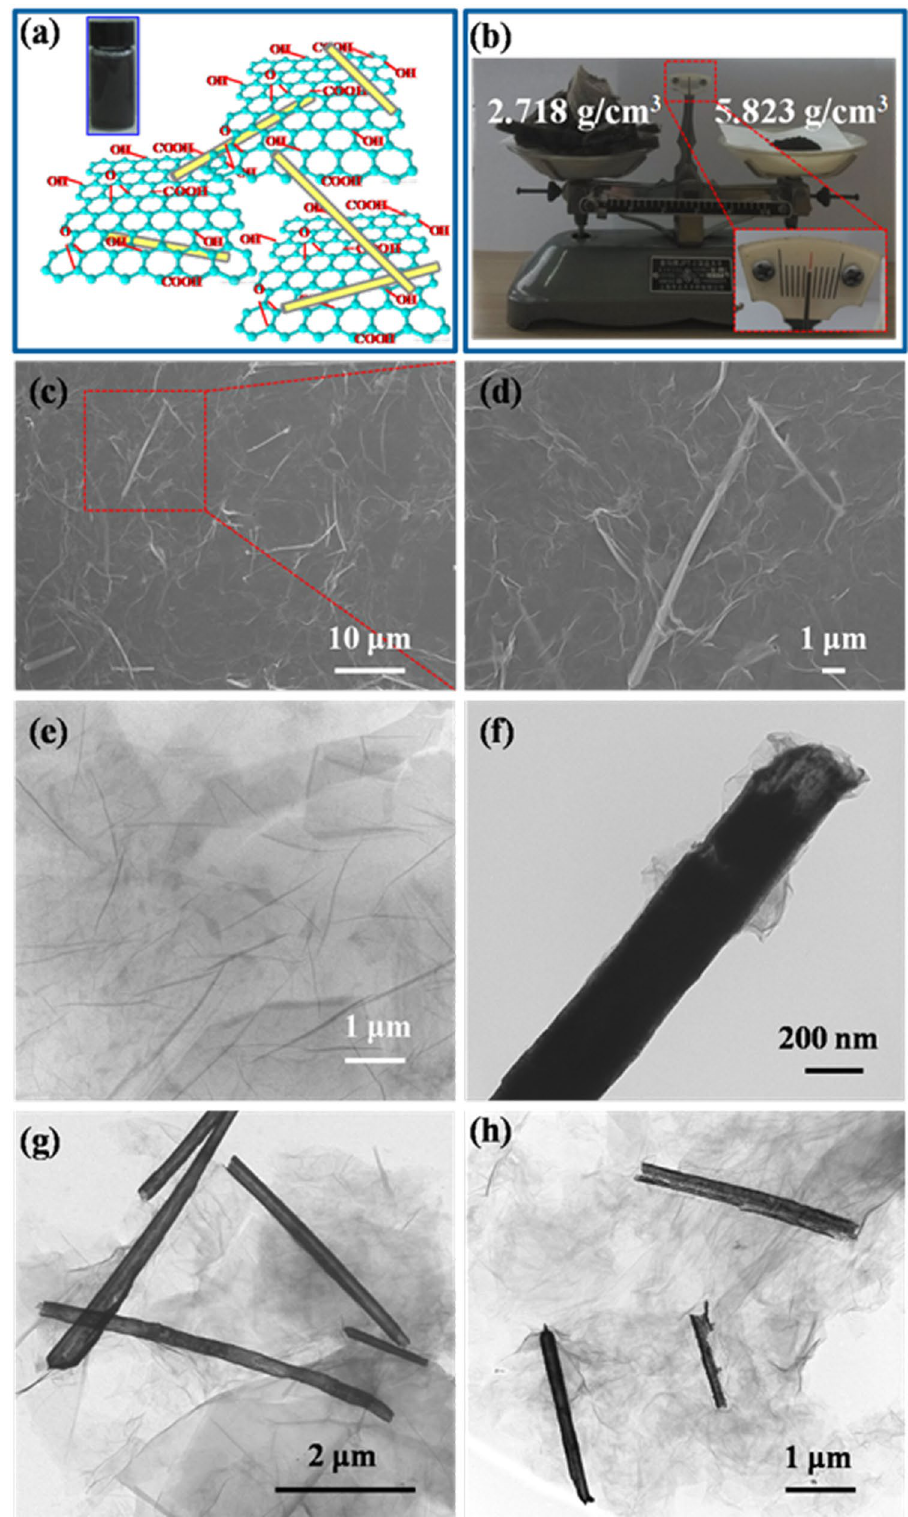
Figure 4. ( a ) Illustration of the Cu@Ni NWs/GO composites, and the photograph of Cu@Ni NWs/GO (1:1) suspension (upper left). ( b ) The lyophilized Cu@Ni NWs/GO (1:1) (left) and Cu@Ni NWs (right) with the same mass on the balance. ( c , d ) SEM images of Cu@Ni NWs/GO (1:1) with different magnifications. TEM images of GO ( e ), Cu@Ni NWs/GO (1:0.5) ( f ), Cu@Ni NWs/GO (1:1) ( g ), and Cu@Ni NWs/GO (1:2) ( h